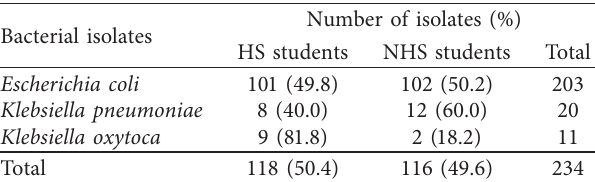
Table 1: Distribution of E. coli and Klebsiella species among HS and NHS